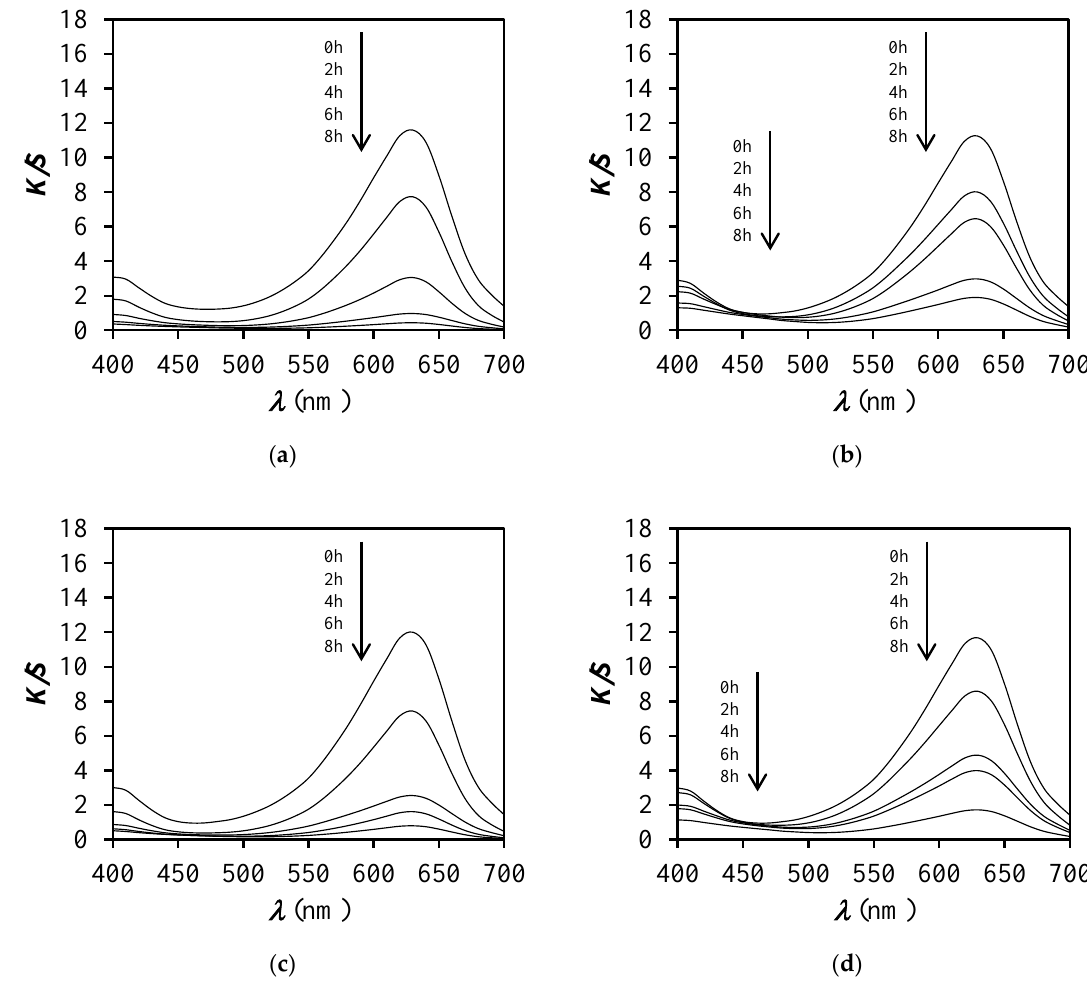
Figure 10. K / S values vs. wavelength ( λ ) for PA_D and PA_DF before and after exposure to a Xenotest apparatus for 2, 4, 6, and 8 h and immersion in buffer solutions of pH 5 and 6. ( a ) Sample PA_D at pH 5; ( b ) Sample PA_ DF at pH 5 ( c ) Sample PA_D at pH 6 ( d ) Sample PA _DF at pH 6.